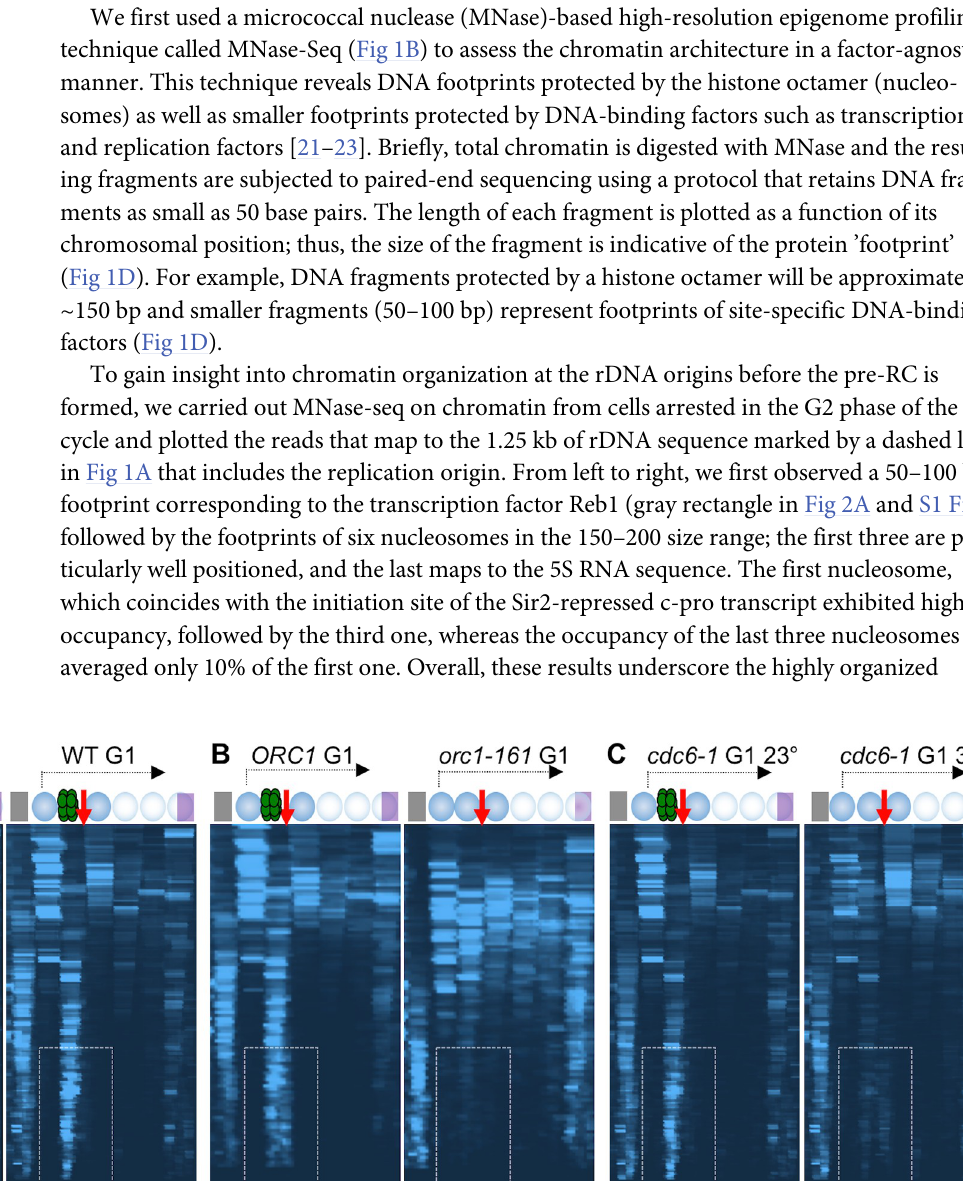
PLOS Genetics | https://doi.org/10.1371/journal.pgen.1008138 May 13,